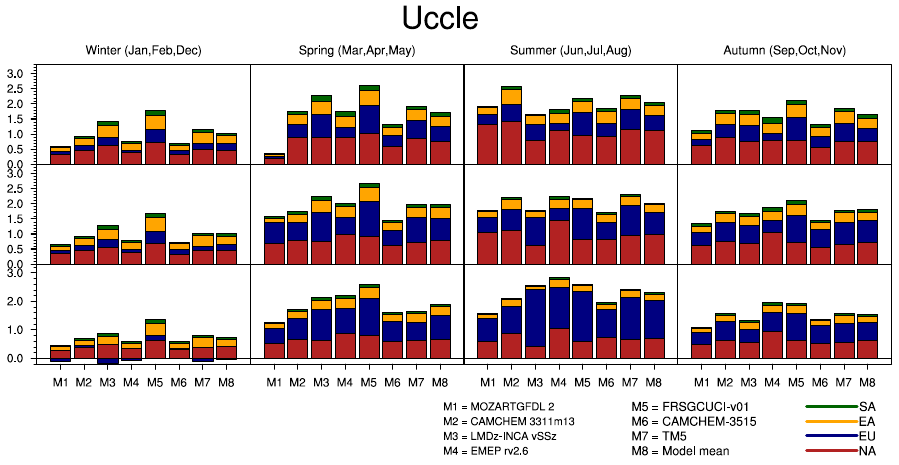
Fig. 18: Effects above Uccle on O 3 (ppb) of 20% reductions in emissions in the four source regions in winter, spring, summer and autumn calculated with the first seven models (and the model mean) listed in Table 1 (see legend above). Results are aggregated to LT (900 - 700hPa), MT (700 - 500hPa) and UT (500 - 300hPa).